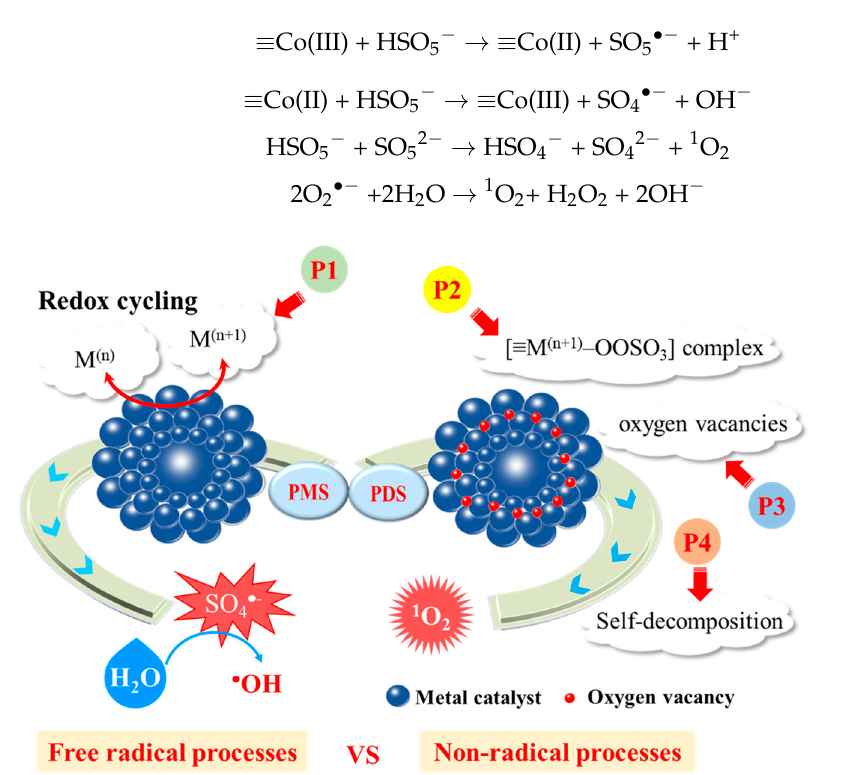
Figure 5. Schematic illustration of pathways of PMS/PDS activation in metal-catalyzed heteroge- neous systems. P1: redox cycling; P2: formation of metal-PMS/PDS complex; P3: generation of oxygen vacancies; P4: PMS/PDS self-decomposition.